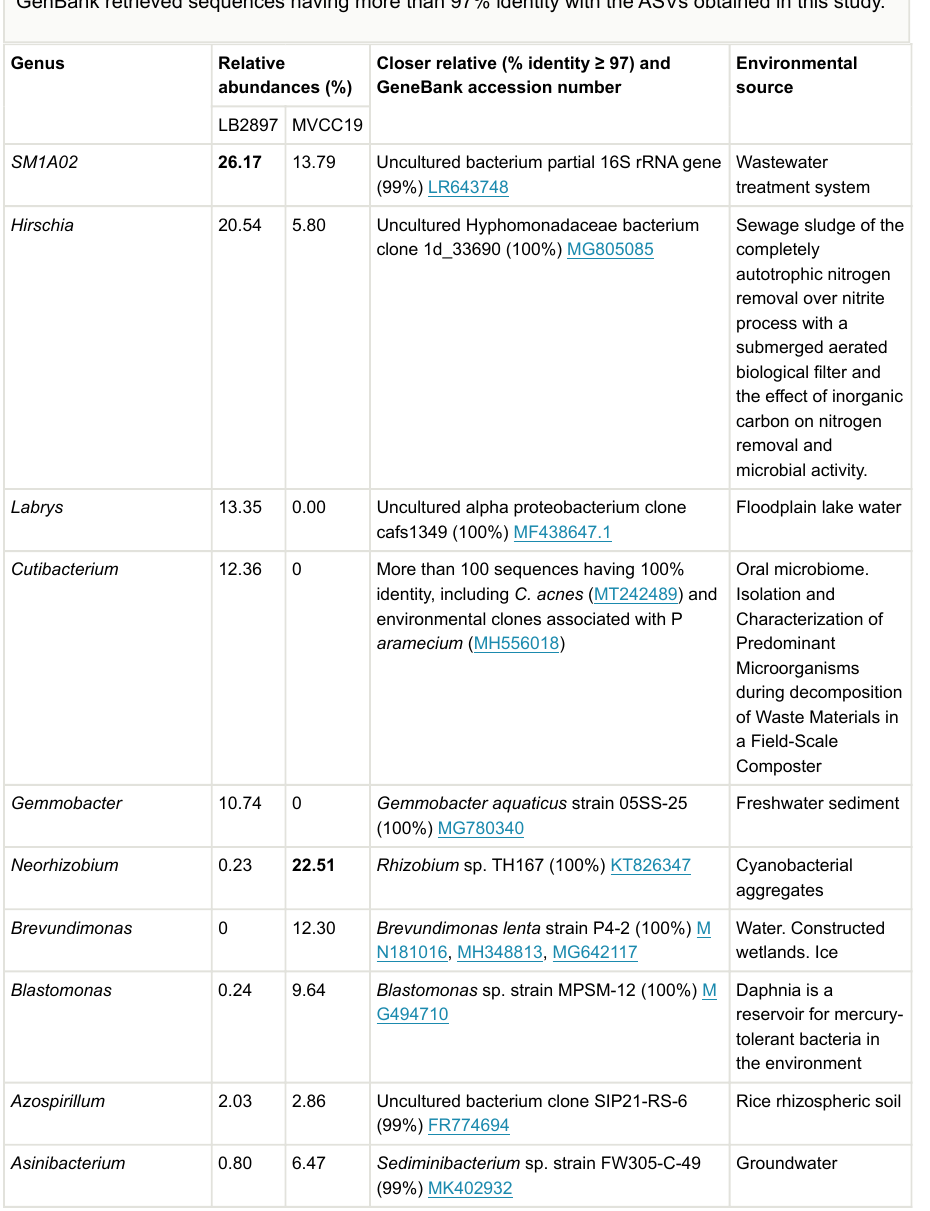
Brevundimonas (Caulobacteraceae family, Alphaproteobacteria class) and 9.8% Emticicia (family Cytophagaceae, phylum Bacteroidetes). Table 2. GenBank retrieved sequences having more than 97% identity with the ASVs obtained in this